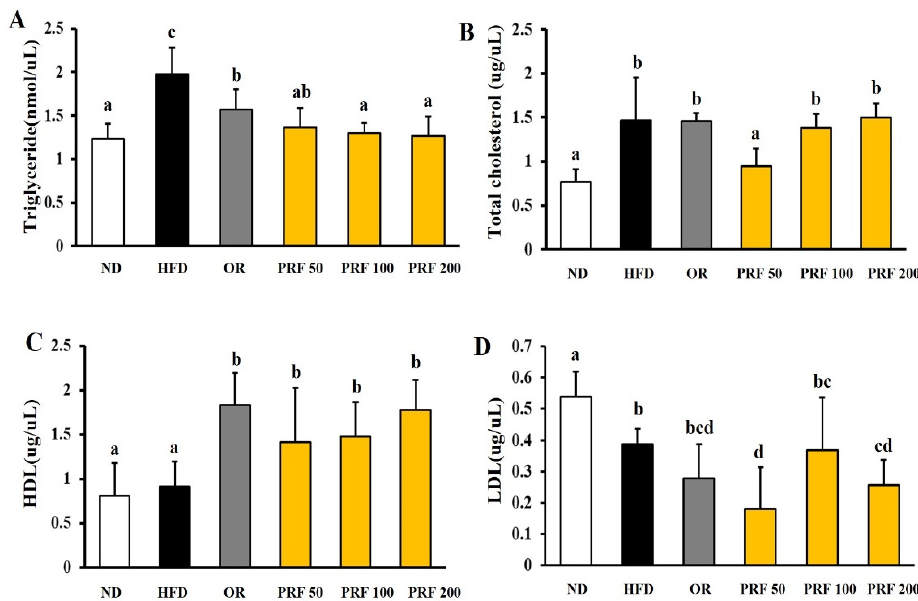
Figure 2. Effect of PRF on serum lipid profiles in HFD-induced obese mice. HFD-induced obese mice were orally administered the drug under an HFD for a further 5 weeks. ( A ) Triglyceride levels, ( B ) total cholesterol levels, ( C ) HDL-cholesterol levels, ( D ) LDL-cholesterol levels. ND, normal diet; HFD, high-fat diet; OR, HFD + 15.6 mg of orlistat; PRF 50, PRF 100, and PRF 200, HFD + 50, 100, and 200 mg of PRF, respectively. The results are expressed as the means ± SDs ( n = 7). The values with different letters (a–d) are significantly different ( p < 0.05) from each other according to one-way ANOVA and Duncan’s multiple-range test.